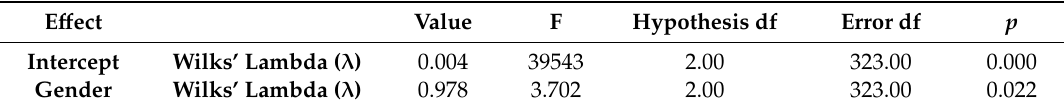
Table 3. The results of the MANOVA test on the Intercultural Sensitivity and Ethnocentrism levels of theology students by